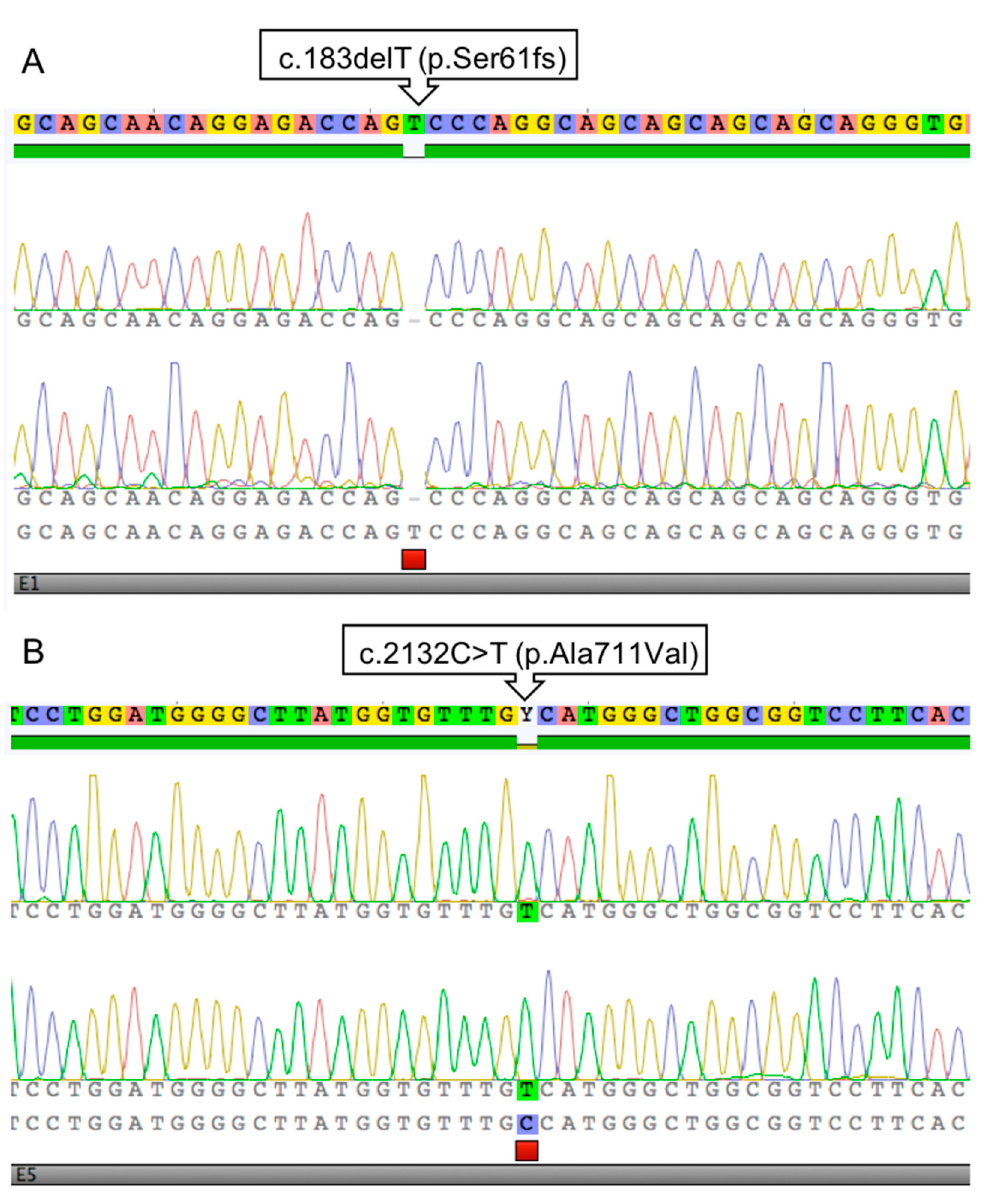
Figure 1. Sanger sequencing electrophoretograms presenting the c.183delT (p.Ser61fs) variant in Case #1 ( A ) and c.2132C>T p.Ala711Val) in Case #2 ( B ).